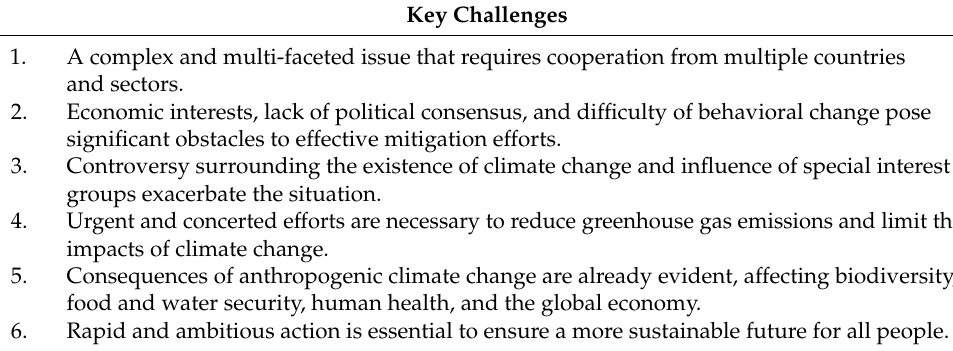
Table 2. Key challenges concerning the discussion about climate